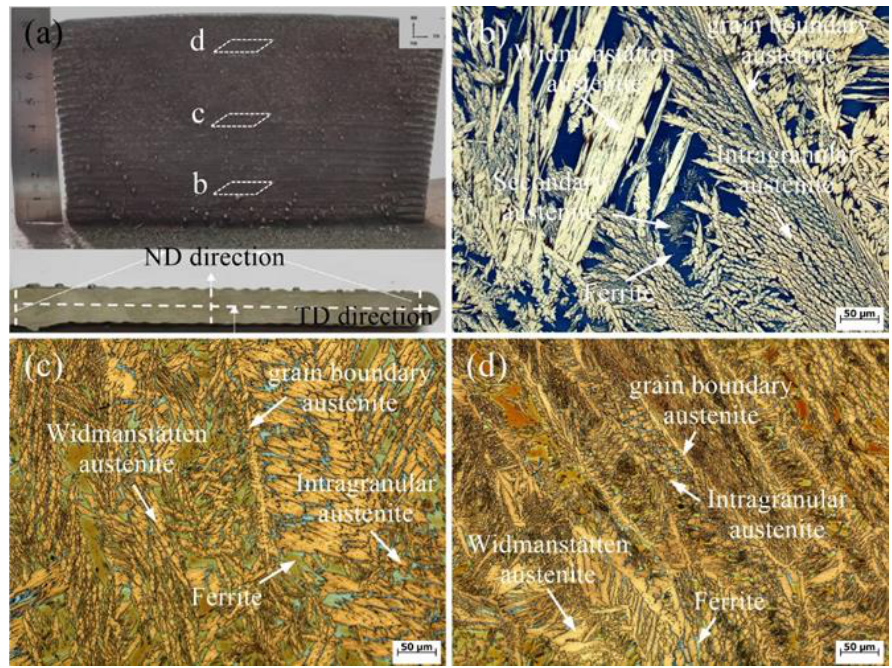
Figure 2. The microstructure of CMT-WAAM 2205 DSS additive parts in different areas: ( a ) schematic diagram of sampling location; ( b ) bottom area; ( c ) top area; ( d ) top area.